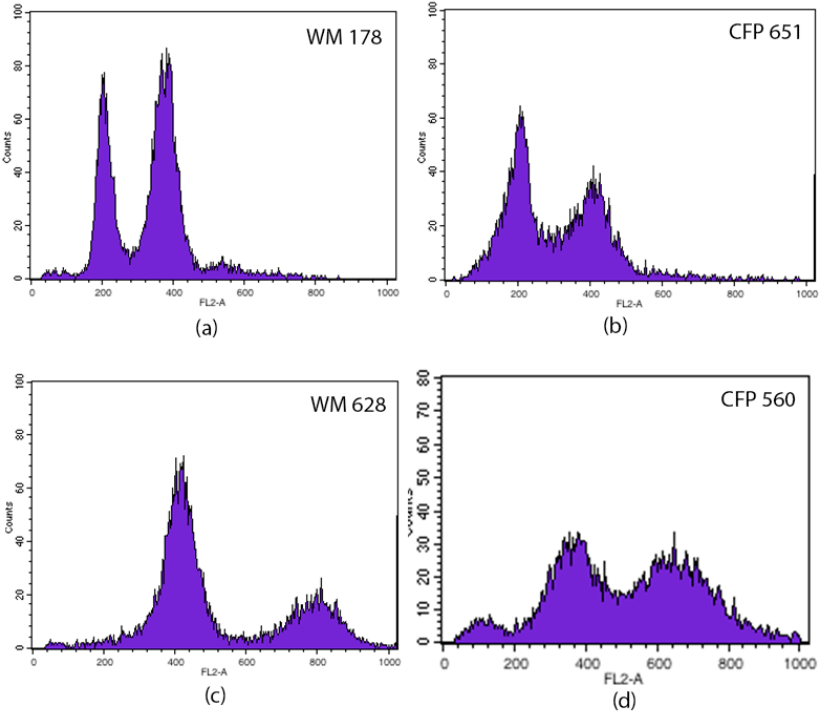
Figure 1. Histograms of DNA content from representative haploid ( b ) and diploid ( d ) strains, and haploid ( a ) and diploid ( c ) standard strains. The abscissa represents the channel numbers in the proportion of their fluorescence intensities and the ordinate shows the number of cells.